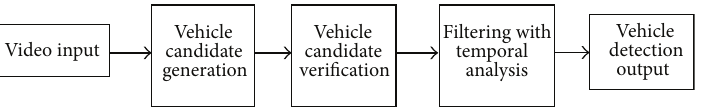
Figure 1: Overall framework of vehicle